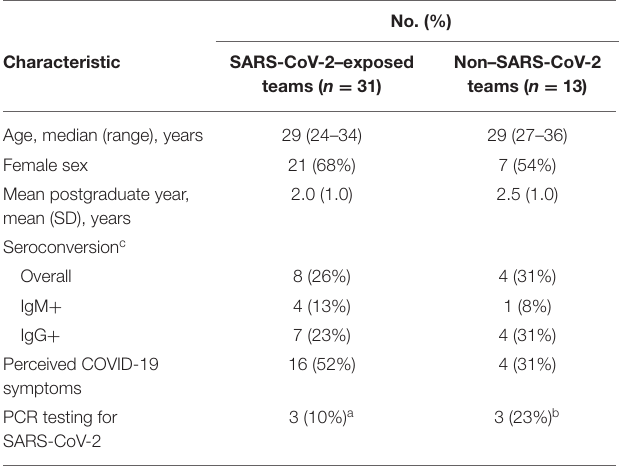
TABLE 1 | Descriptive characteristics and SARS-CoV-2 seroconversion of study participants separated by SARS-CoV-2 exposure.